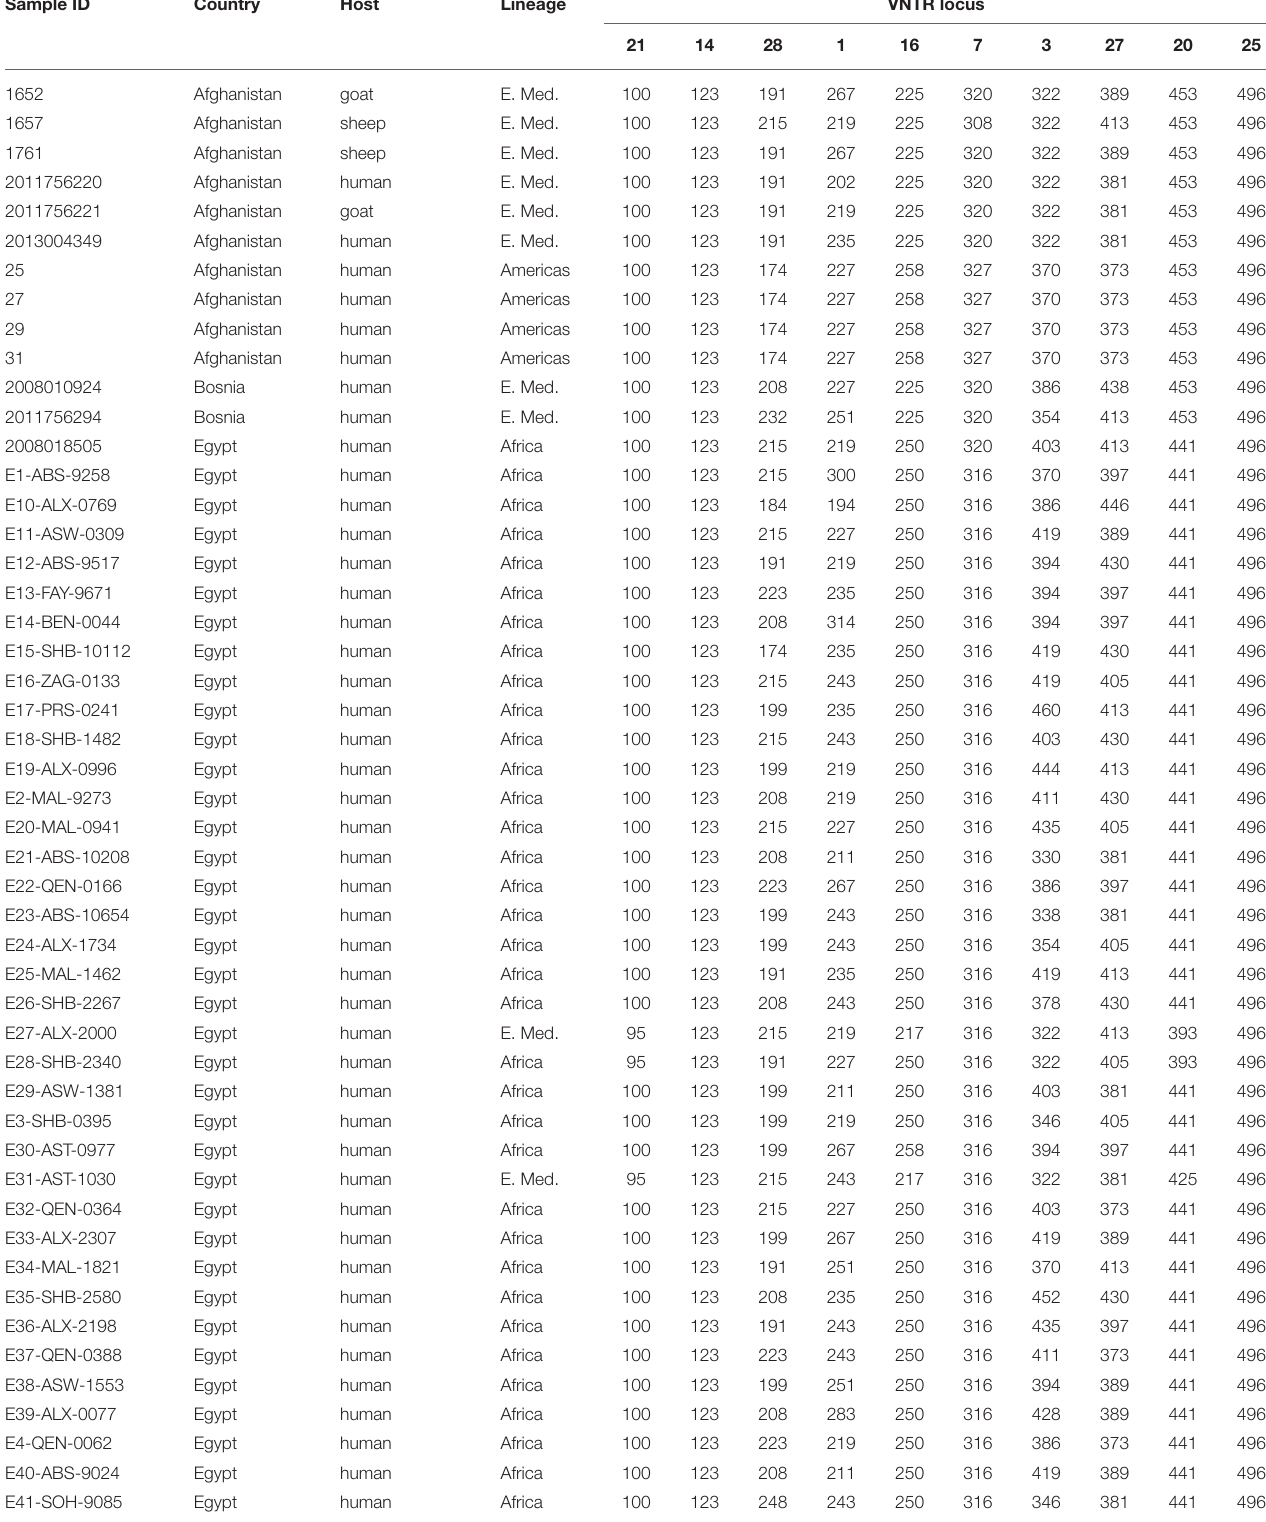
TABLE 3 | MLVA-10 genotypes for 221 isolates of Brucella melitensis from the Middle East. Isolates from additional regions added for context. Sample